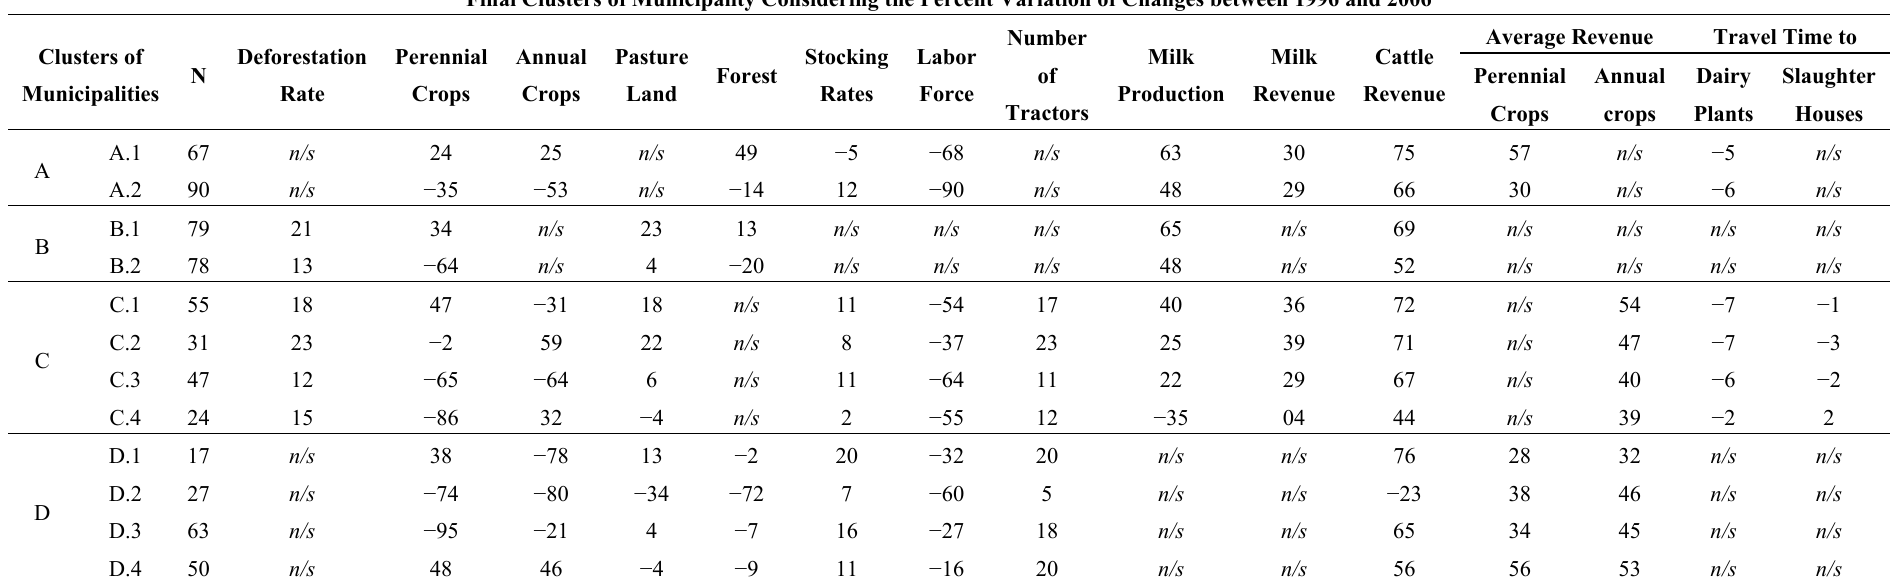
Table 5. Results of k -means clustering based on land use/cover changes and intensification indicators at the municipality level. Final Clusters of Municipality Considering the Percent Variation of Changes between 1996 and